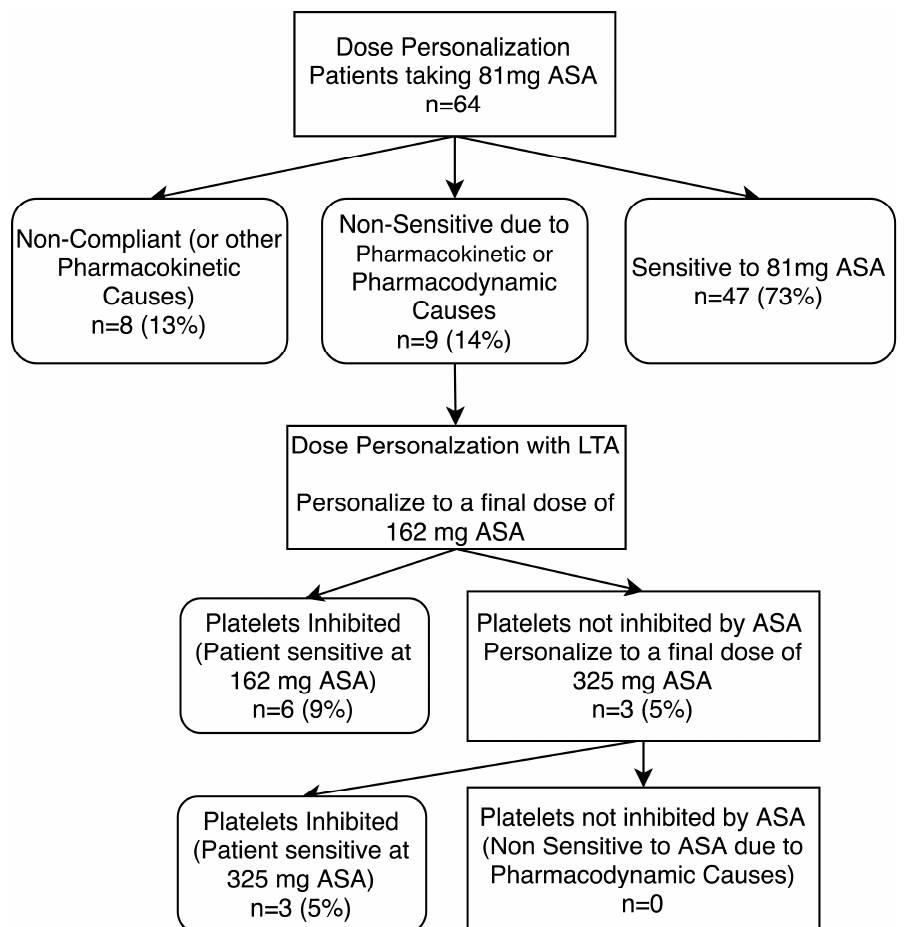
Figure 6. Dose personalization of 81 mg aspirin (ASA) compliant patients. Patients non-sensitive to 81 mg ASA therapy underwent ASA dose personalization at 162 and 325 mg doses. Platelets were considered not inhibited by ASA if there was evidence of ≥ 20% maximal platelet aggregation during LTA analysis after activation with arachidonic acid. ASA compliance was defined as urinary salicyluric acid levels >5.25 µg/mL. Percentages shown are in comparison to all patients recruited to the study ( n = 64).